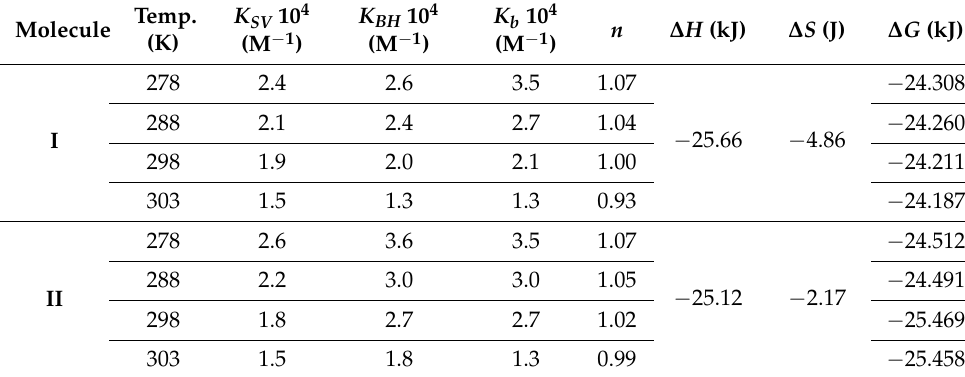
Table 3. Stern–Volmer quenching constant ( K SV ), binding constant determined using Benesi– Hildebrand ( K BH ) and Scatchard ( K b ) methods and thermodynamic parameters (binding number ( n ), changes in enthalpy ( ∆ H ), entropy ( ∆ S ), and Gibb’s free energy ( ∆ G ) of the binding process) at different temperatures. Temp. Molecule